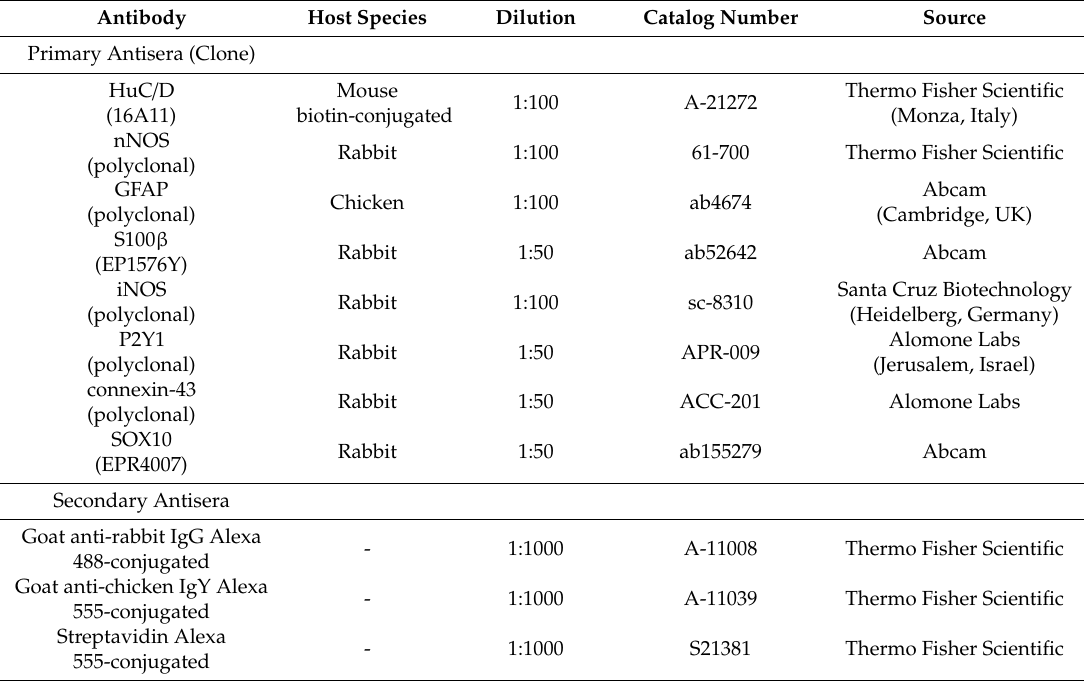
Table 1. Primary and secondary antisera and their respective dilutions used for immunohistochemistry on ileal whole-mount